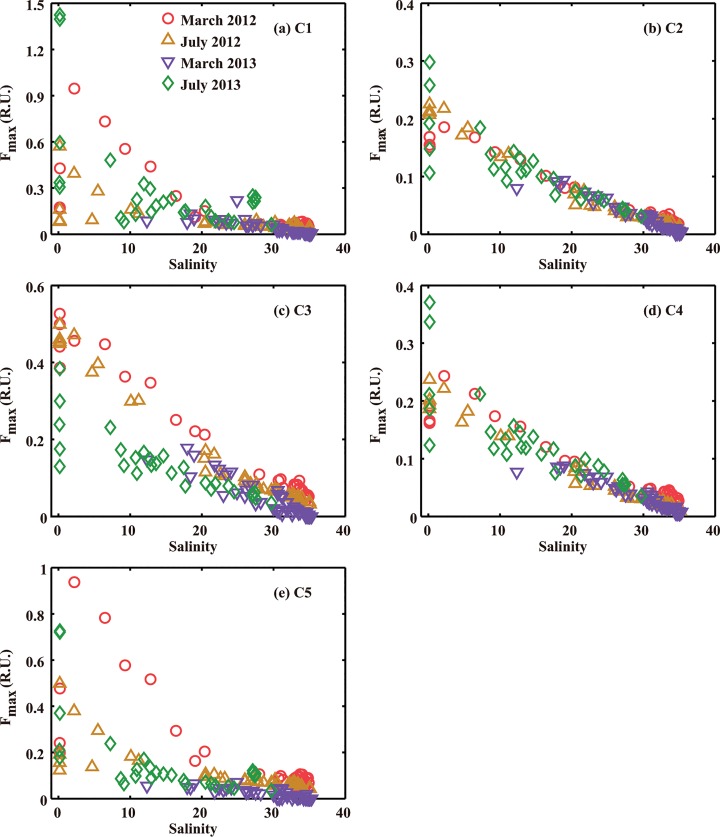
Fluorescence intensity (Fmax) of five fluorescent components (C1-C5) versus salinity.